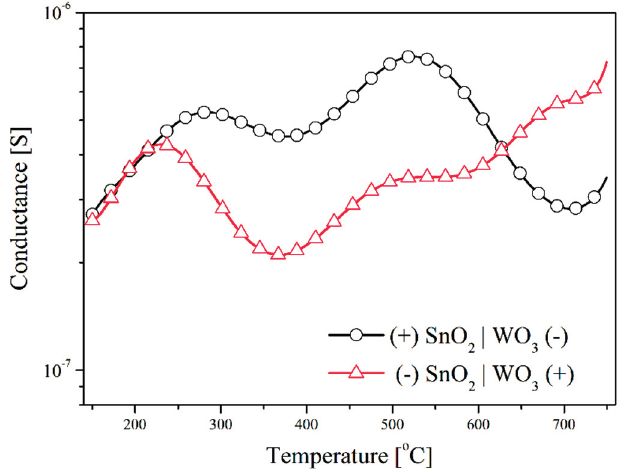
Figure 9. Temperature characteristics of TS-conductance in the atmosphere of 50 ppm H 2 S of sensor with a SnO 2 |WO 3 heterocontact in function of polarization